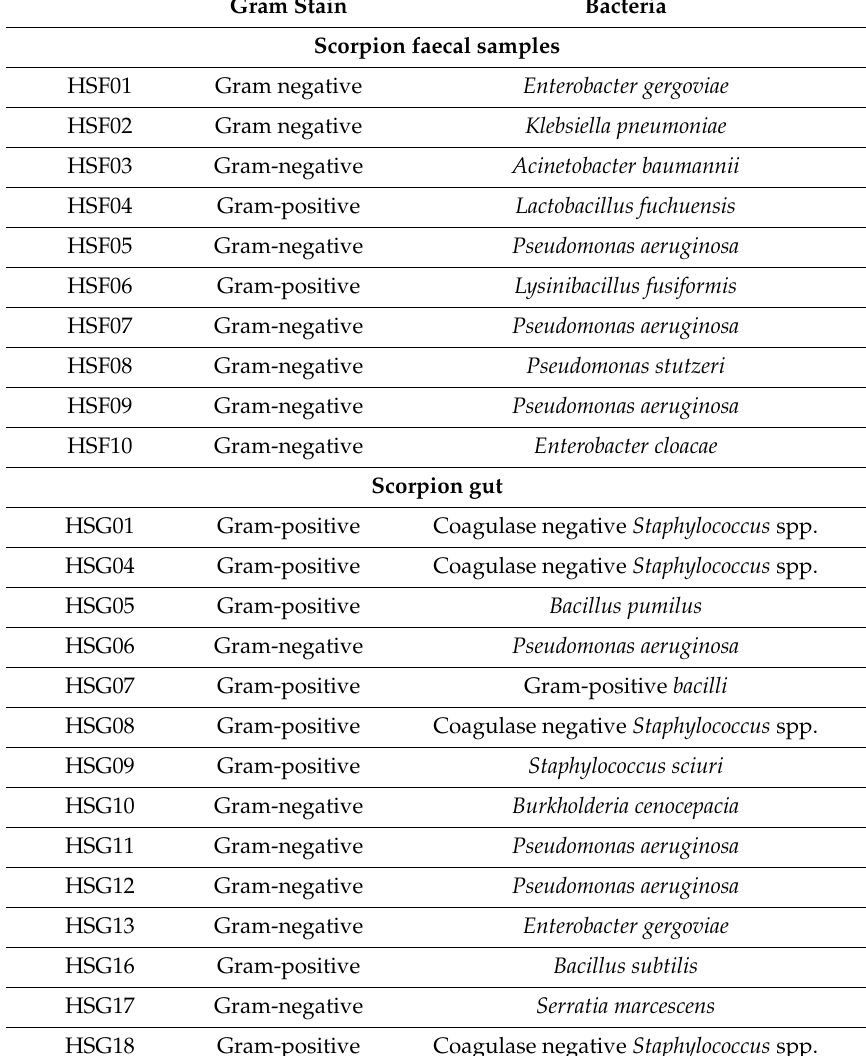
Table 1. Bacterial species isolated from the feces and gastrointestinal tract of the scorpion H. spinifer